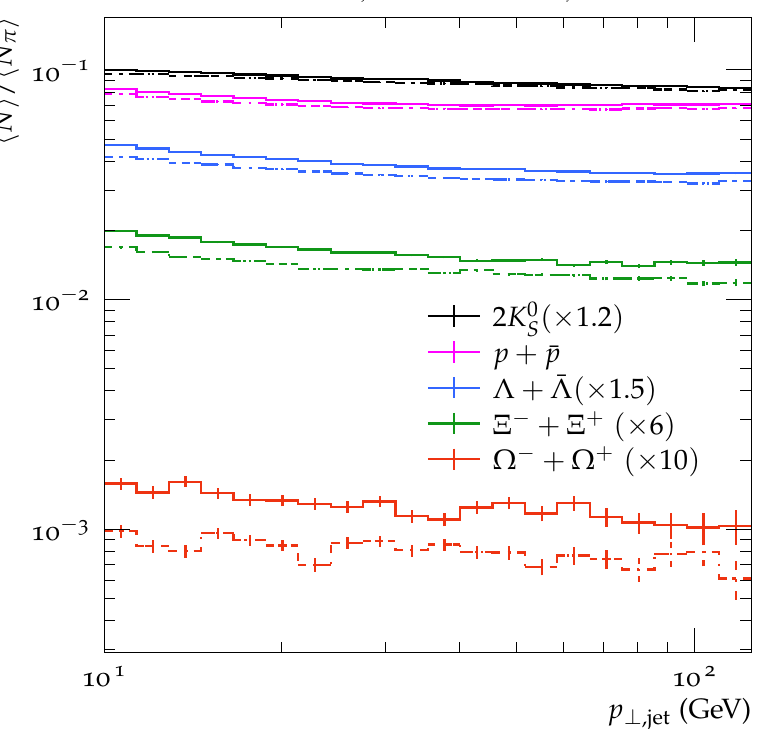
Figure 6: Yield ratio of different strange hadrons and protons to pions in the jet cone, = 0.4 vs. p for R ⊥ ,jet , scaled by factors to show them clearly. Solid lines are with rope j hadronization and dot-dashed lines are for default P YTHIA